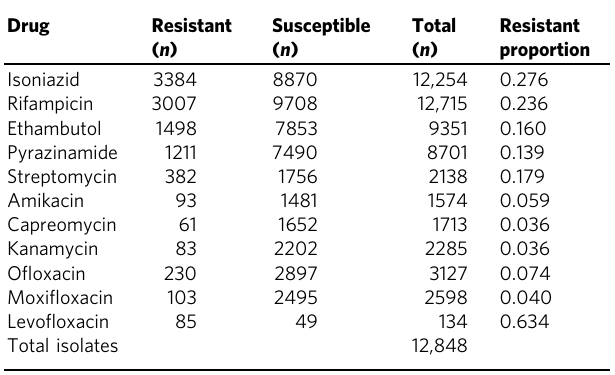
Table 2 Test set isolate